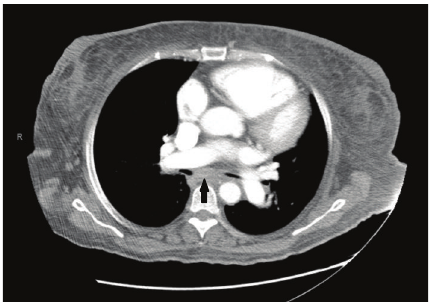
Figure 1:ChestCTshowing mediastinal lymphadenopathy